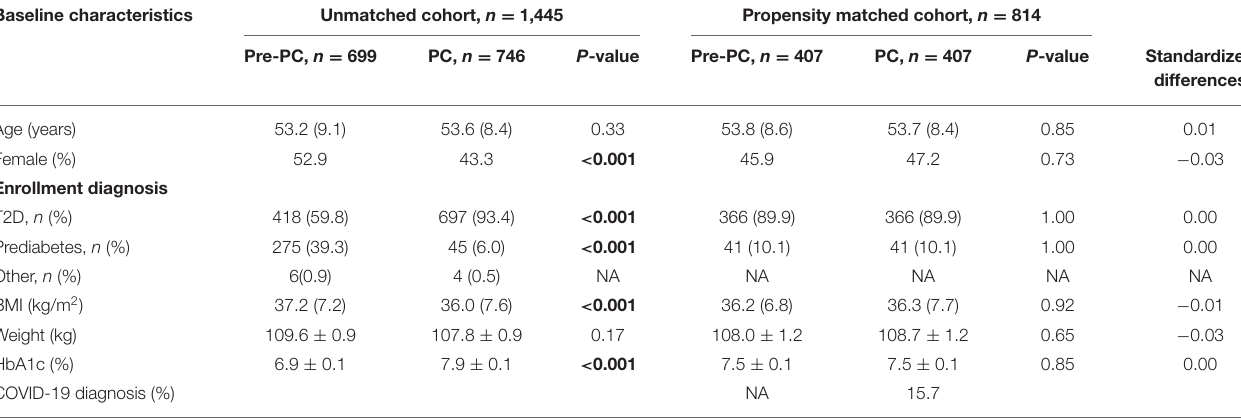
TABLE 1 | Baseline characteristics of unmatched and matched pre-pandemic cohort (Pre-PC) and pandemic cohort (PC). Baseline